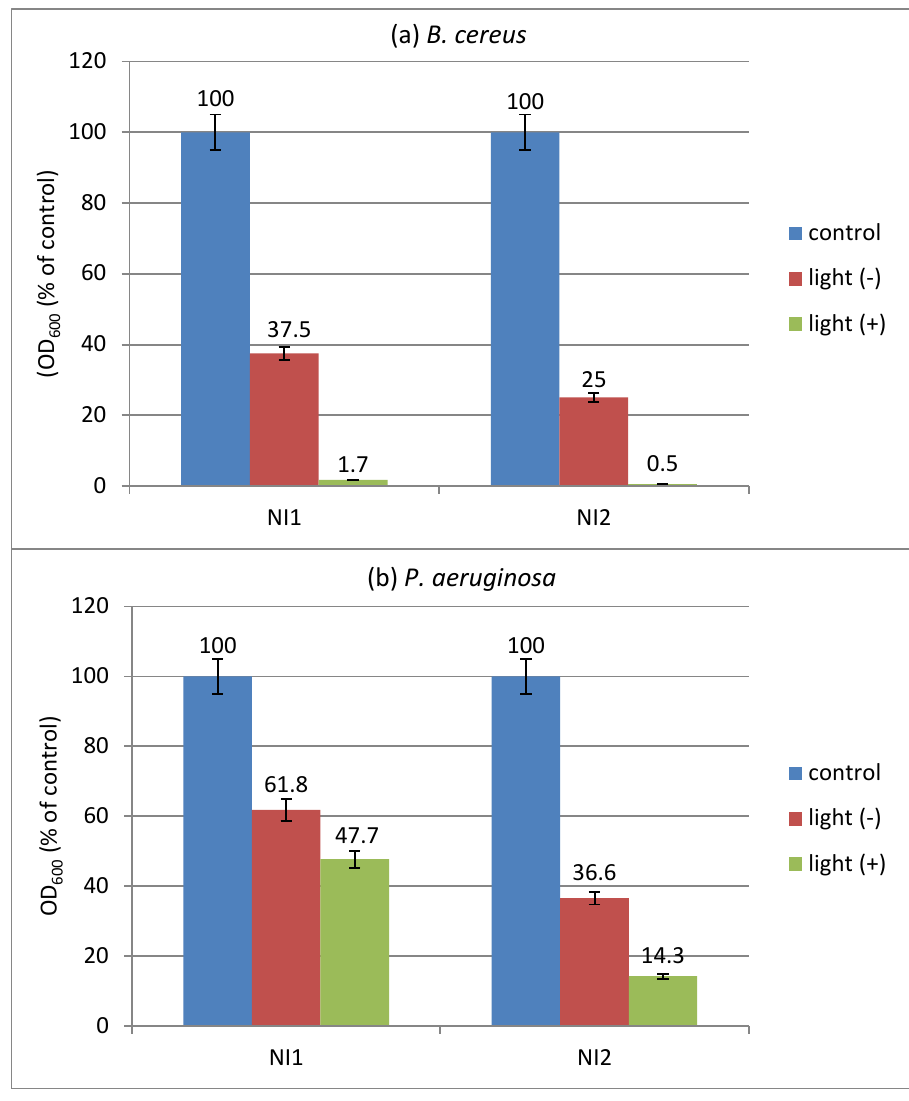
Figure 5. The effect of light irradiation on the antimicrobial action of the compounds towards ( a ) B. cereus (at concentration of NI1 250 µg/mL and of NI2 20 µg/mL) and ( b ) P. aeruginosa (concentration of NI1 and NI2 350 µg/mL).